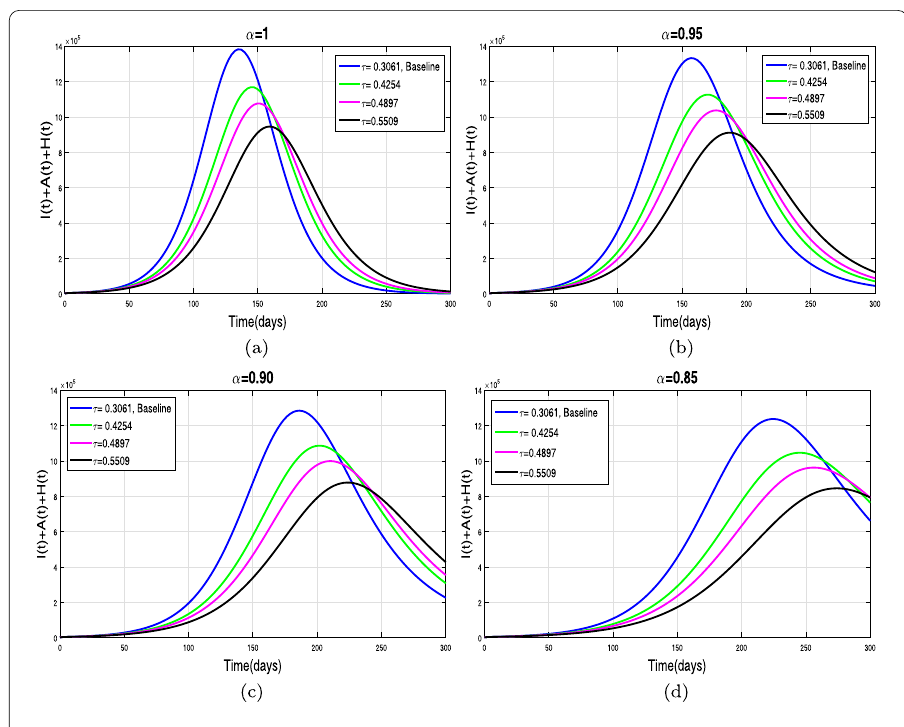
Figure 6 The impact of hospitalization (self-isolation) rate on I , A , and H individuals for α = 1, α = 0.95, α = 0.90, α = 0.85